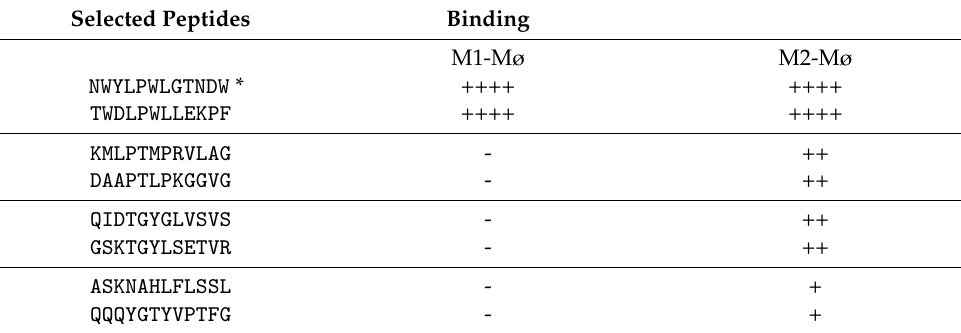
Table 2. Sequences of the phage-displayed peptides. Selected Peptides Binding M1-Mø